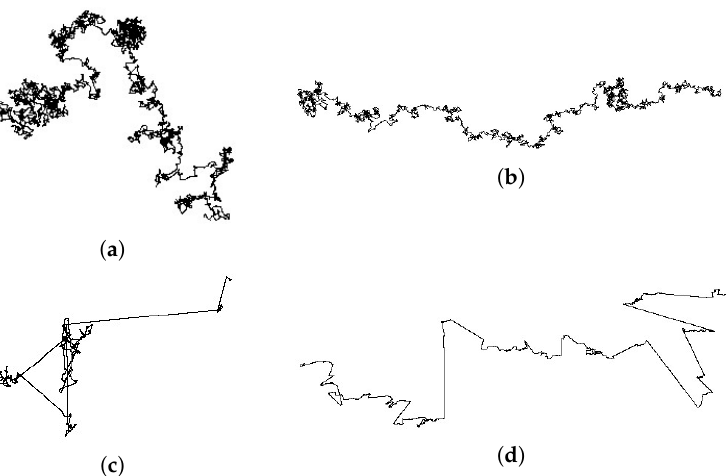
Figure 2. Comparison of Gaussian (Brownian) and Lévy flight in open space. The top panels show diffusion caused by the random Gaussian distribution of steps and the bottom ones show Cauchy distributed steps. In the left panels, there is no external drift, while in the right panels there is a drift along the horizontal axis. ( a ) The trajectory of Brownian motion without drift, ( b ) trajectory of Brownian motion with drift, ( c ) trajectory of Lévy flight without drift, and ( d ) trajectory of Lévy flight with